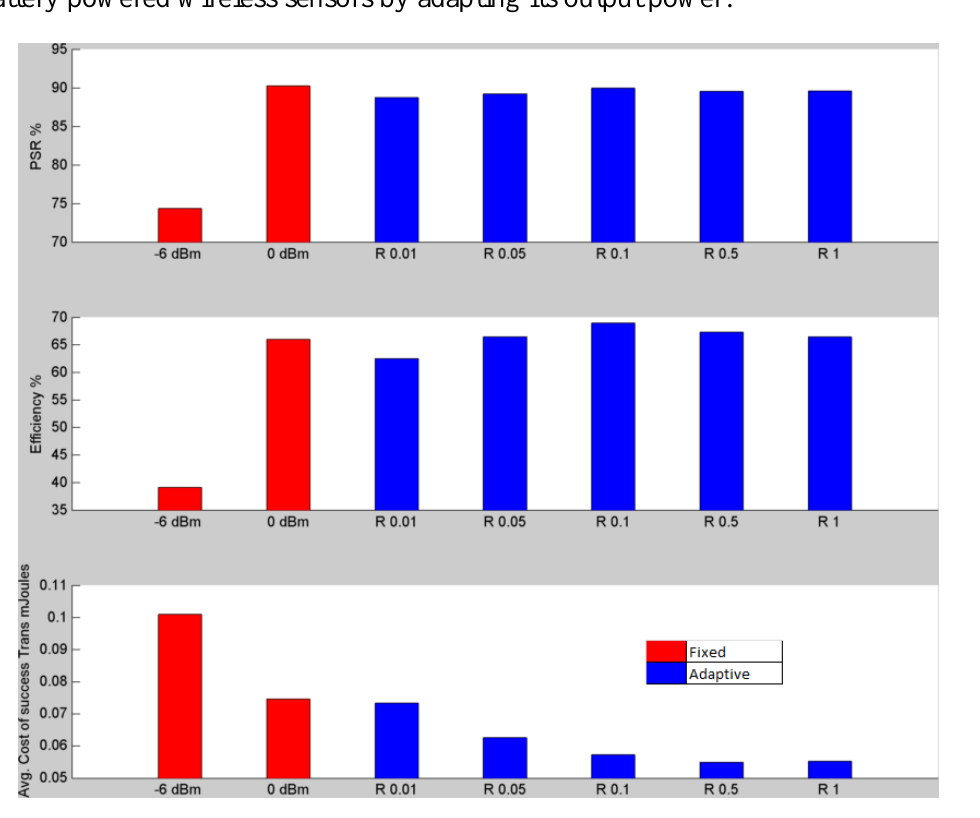
Figure 8. Comparison of the efficiency and average cost of successful transmission based on the PSR and data collected during a gathering in a house. The minimum energy consumption of fixed power is achieved at 0 dBm. In terms of energy efficiency, the adaptive protocol consumes 26% less energy than the fixed power transmission at 0 dBm when R = 0.5. The protocol efficiencies of both fixed (at 0 dBm) and adaptive R = 0.5) are the